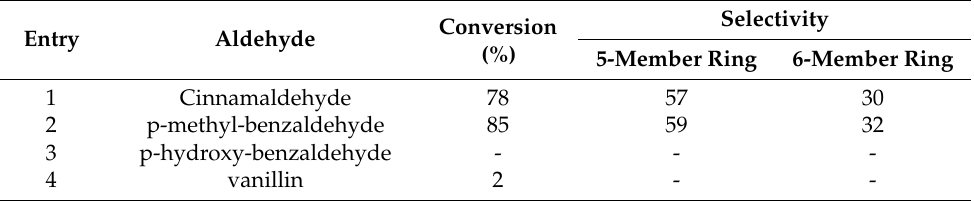
Table 9. Acetalization of glycerol with varied aromatic aldehydes on the